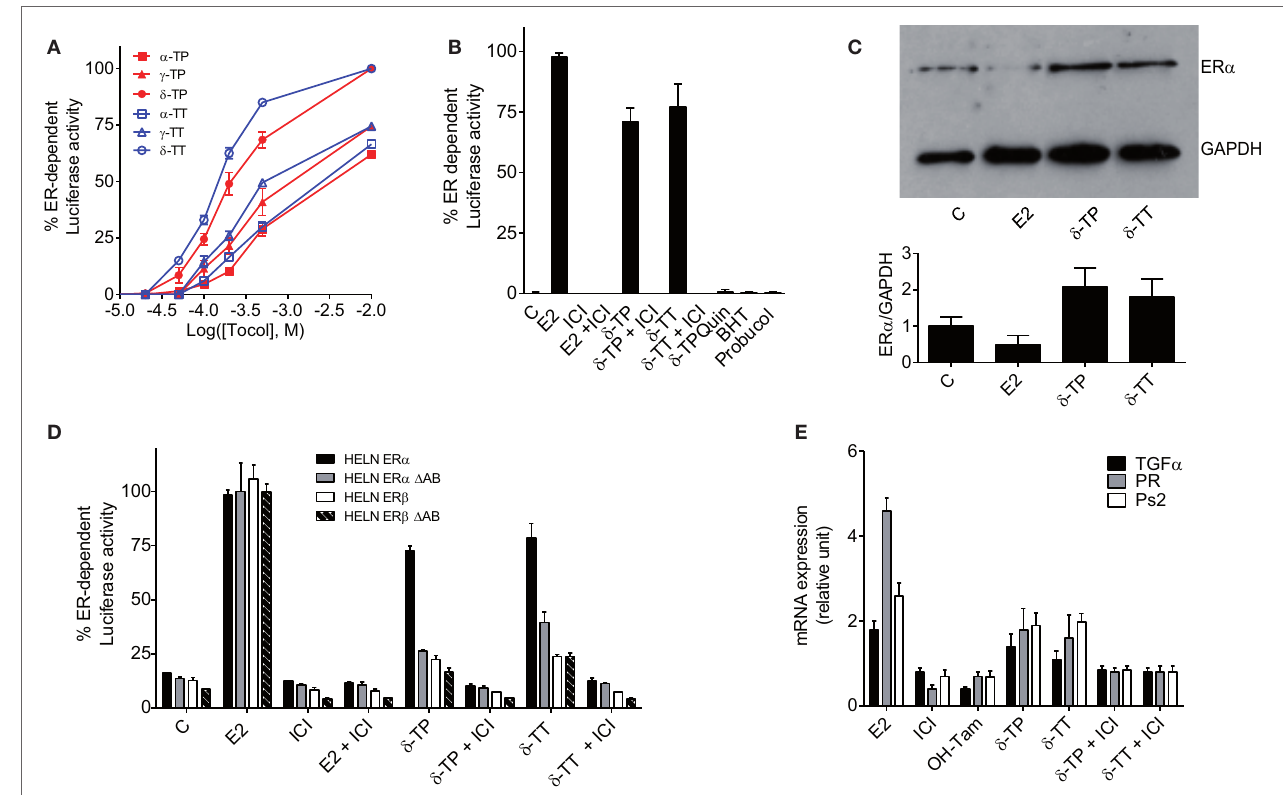
FigUre 3 | Measurement of estrogenicity of tocols in vitro . (a) Dose–response curve of the effect of tocols on MCF-7 cells stably transfected with the ERE- β -globin-tk-Luc plasmid (MELN cells). Results are represented as the percentage of ER-dependent α -, γ -, and δ -TP and α -, γ -, and δ -TT luciferase activity obtained with 10 nM E2 and increasing concentrations of tocols ranging from 10 to 500 μ M. (B) ER-dependent transcriptional modulatory activity of 500 μ M δ -TP, δ -TT, δ -Tocopherolquinone ( δ -TPQuin), butylated hydroxytoluene (BHT), and probucol in MELN cells. Cells were incubated with either 10 nM 17 β estradiol (E2), 500 μ M δ -TP or 500 μ M δ -TT alone or in combination with 1 μ M pure antiestrogen ICI 164,384 (ICI) or were incubated with 500 μ M δ -TPQuin, 500 μ M BHT or 500 μ M probucol and assayed for luciferase activity. Data shown are the mean values ± SEM from three independent experiments. (c) δ -TP or δ -TT stabilized ER- α in MCF-7 cells. MCF-7 cells were cultured as described in Section “Materials and Methods” and treated with either solvent vehicle (EtOH), 100 nM E2, 500 μ M δ -TP or 500 μ M δ -TT for 3 h. MCF-7 extracts were analyzed for the presence of ER α by western blotting using GAPDH as a control. Visualization was achieved with an Enhanced Chemiluminescence Plus kit and fluorescence was measured by either autoradiography or using a PhosphorImager. The western blot shown is representative of three independent experiments. The ratio of ER α to GAPDH levels in each experiment was determined densitometrically and normalized to control value (taken to be 1). (D) Effect of δ -tocols on estrogen response element-dependent luciferase activity in HELN cells, which are HELA cells transfected with either fully functional ER α or ER β or their mutated versions containing a deletion the AB domain ( Δ AB). Cells were incubated with 10 nM 17 β estradiol (E2), 500 μ M δ -TP or 500 μ M δ -TT alone or in combination with 1 μ M pure antiestrogen ICI 164,384 (ICI) and assayed for luciferase activity. Data shown are the mean values ± SEM from three independent experiments. (e) δ -Tocols modulate the induction of endogenous genes under the control of ER. Cells were treated with solvent vehicle, 10 nM E2, 1 μ M ICI, 1 μ M OH-Tam. Cells were treated with 500 μ M δ -tocols in the presence or in the absence of ICI. The relative expression of TGF α , PR, and Ps2 (TFF1) after 16 h was analyzed by quantitative RT-PCR. Data shown are the mean values ± SEM from three independent